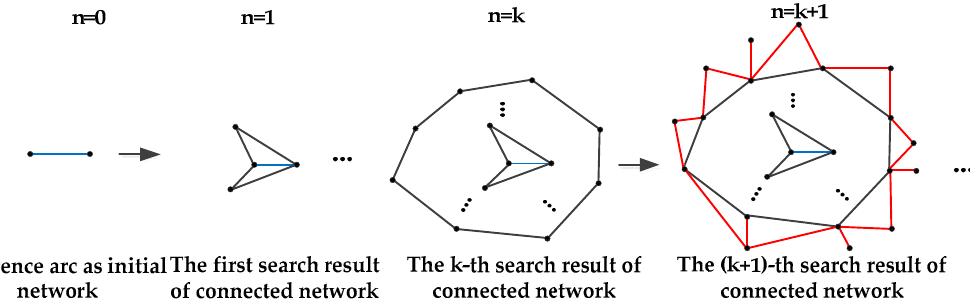
Figure 3. The searching process of the largest connected network.